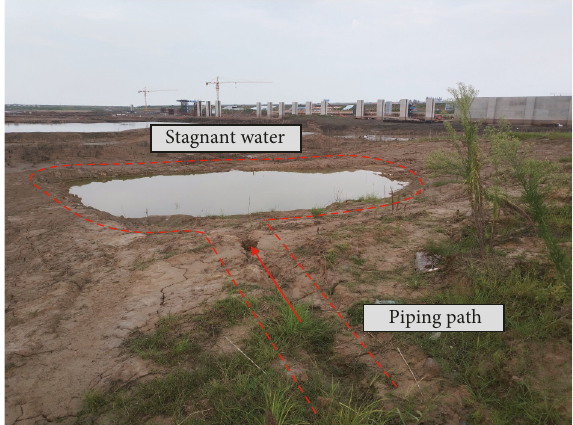
Figure 5: Piping effect at downstream face slope of